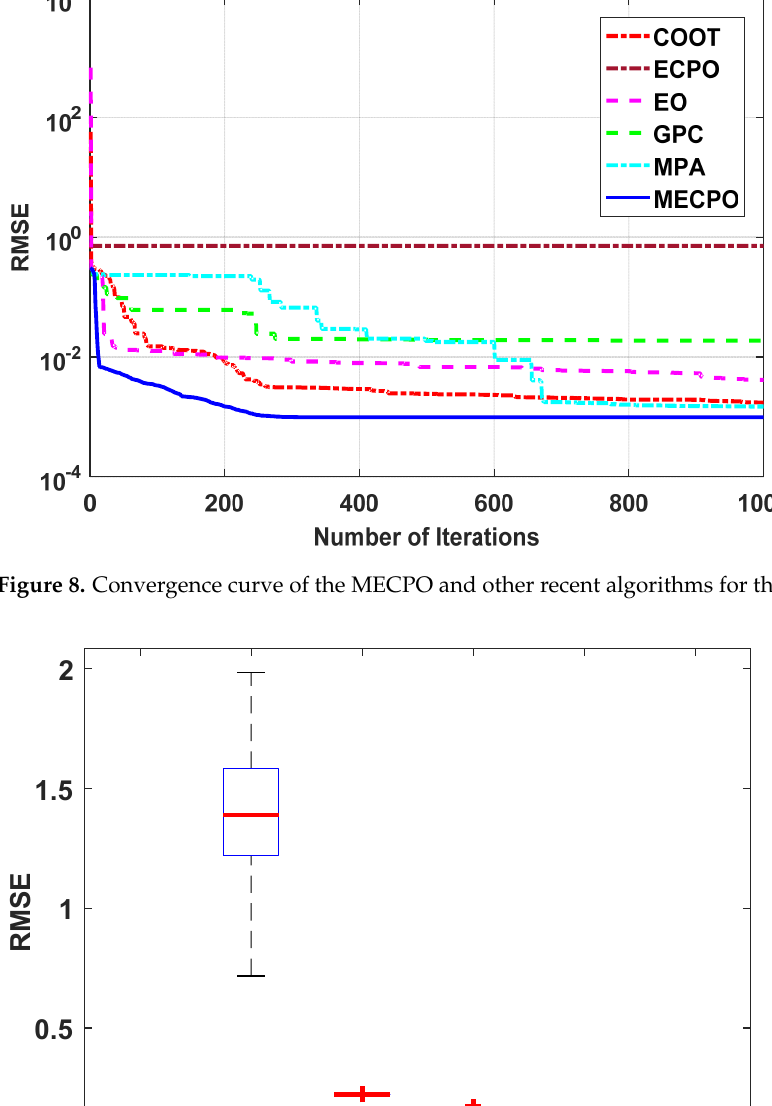
Figure 9. Best RMSE boxplot in 20 runs of the MECPO and other recent algorithms for the SDM. Table 7. Statistical results of the proposed MECPO algorithm and other recent algorithms in the case of the SDM.